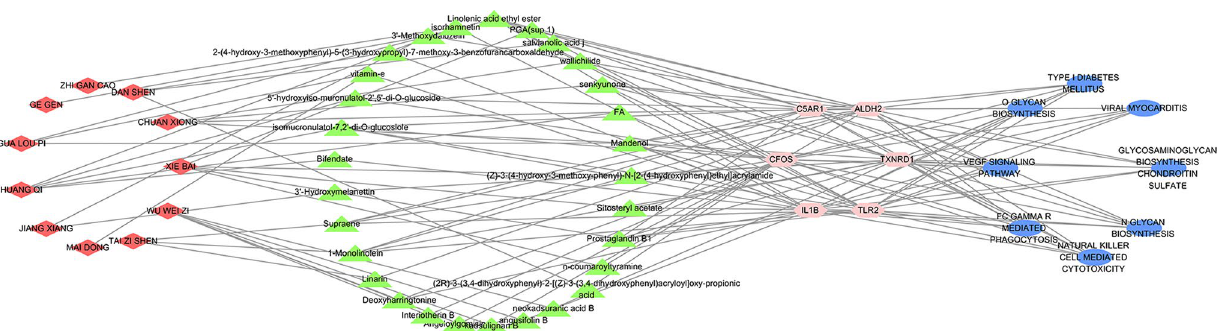
Figure 10. Yixinyin-component-target-pathway network diagram. The figure is drawn by cytoscpe 3.7.0 software (https:// cytos cape. org/). The red node represents the herb in Yixinyin. The green node represents the compounds in Yixinyin. The pink node represents the key gene. The blue node represents the pathway they participate